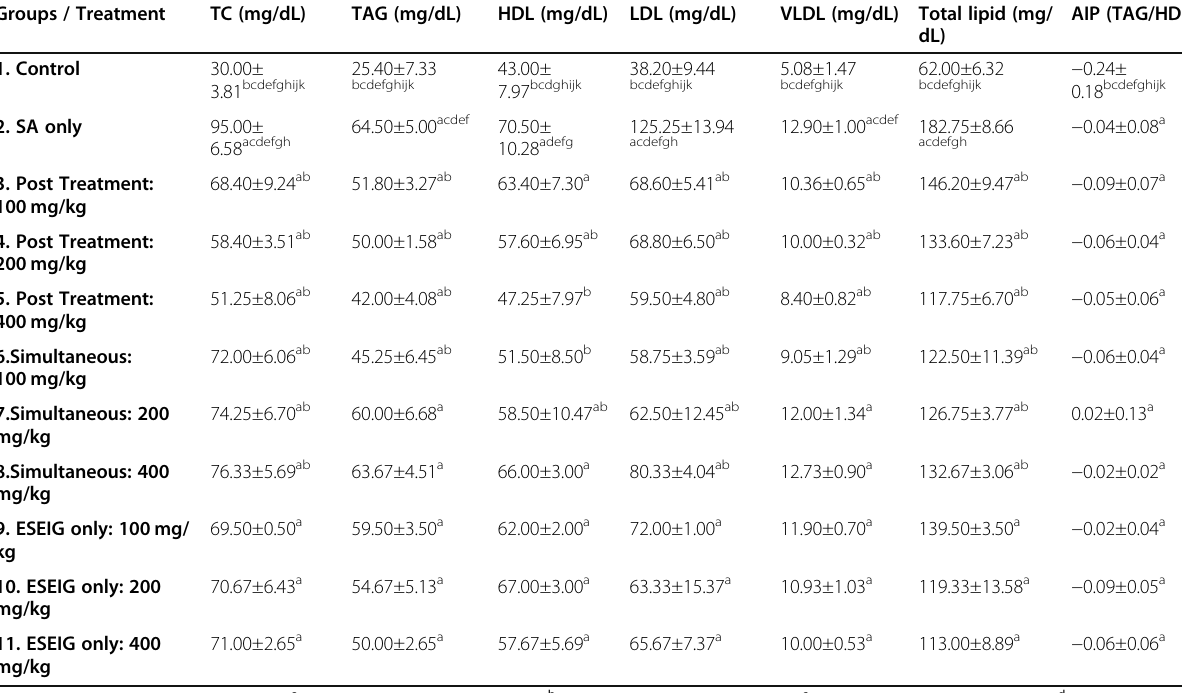
Table 3 Effect of ESEIG on Lipid Profile of Experimental Rats Groups /